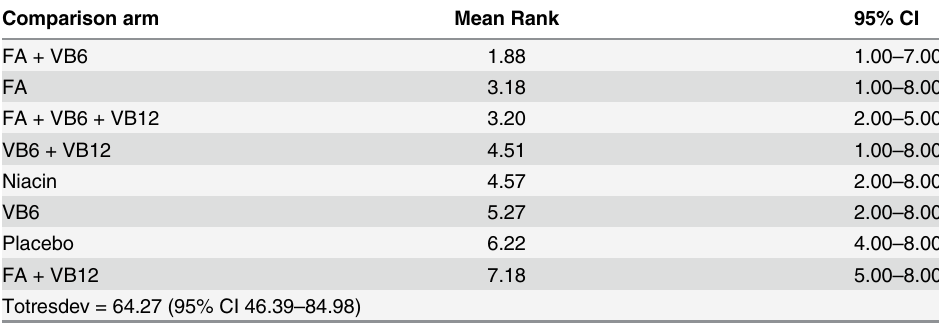
Table 2. Ranking of efficacy of 8 B vitamins interventions with random-effects